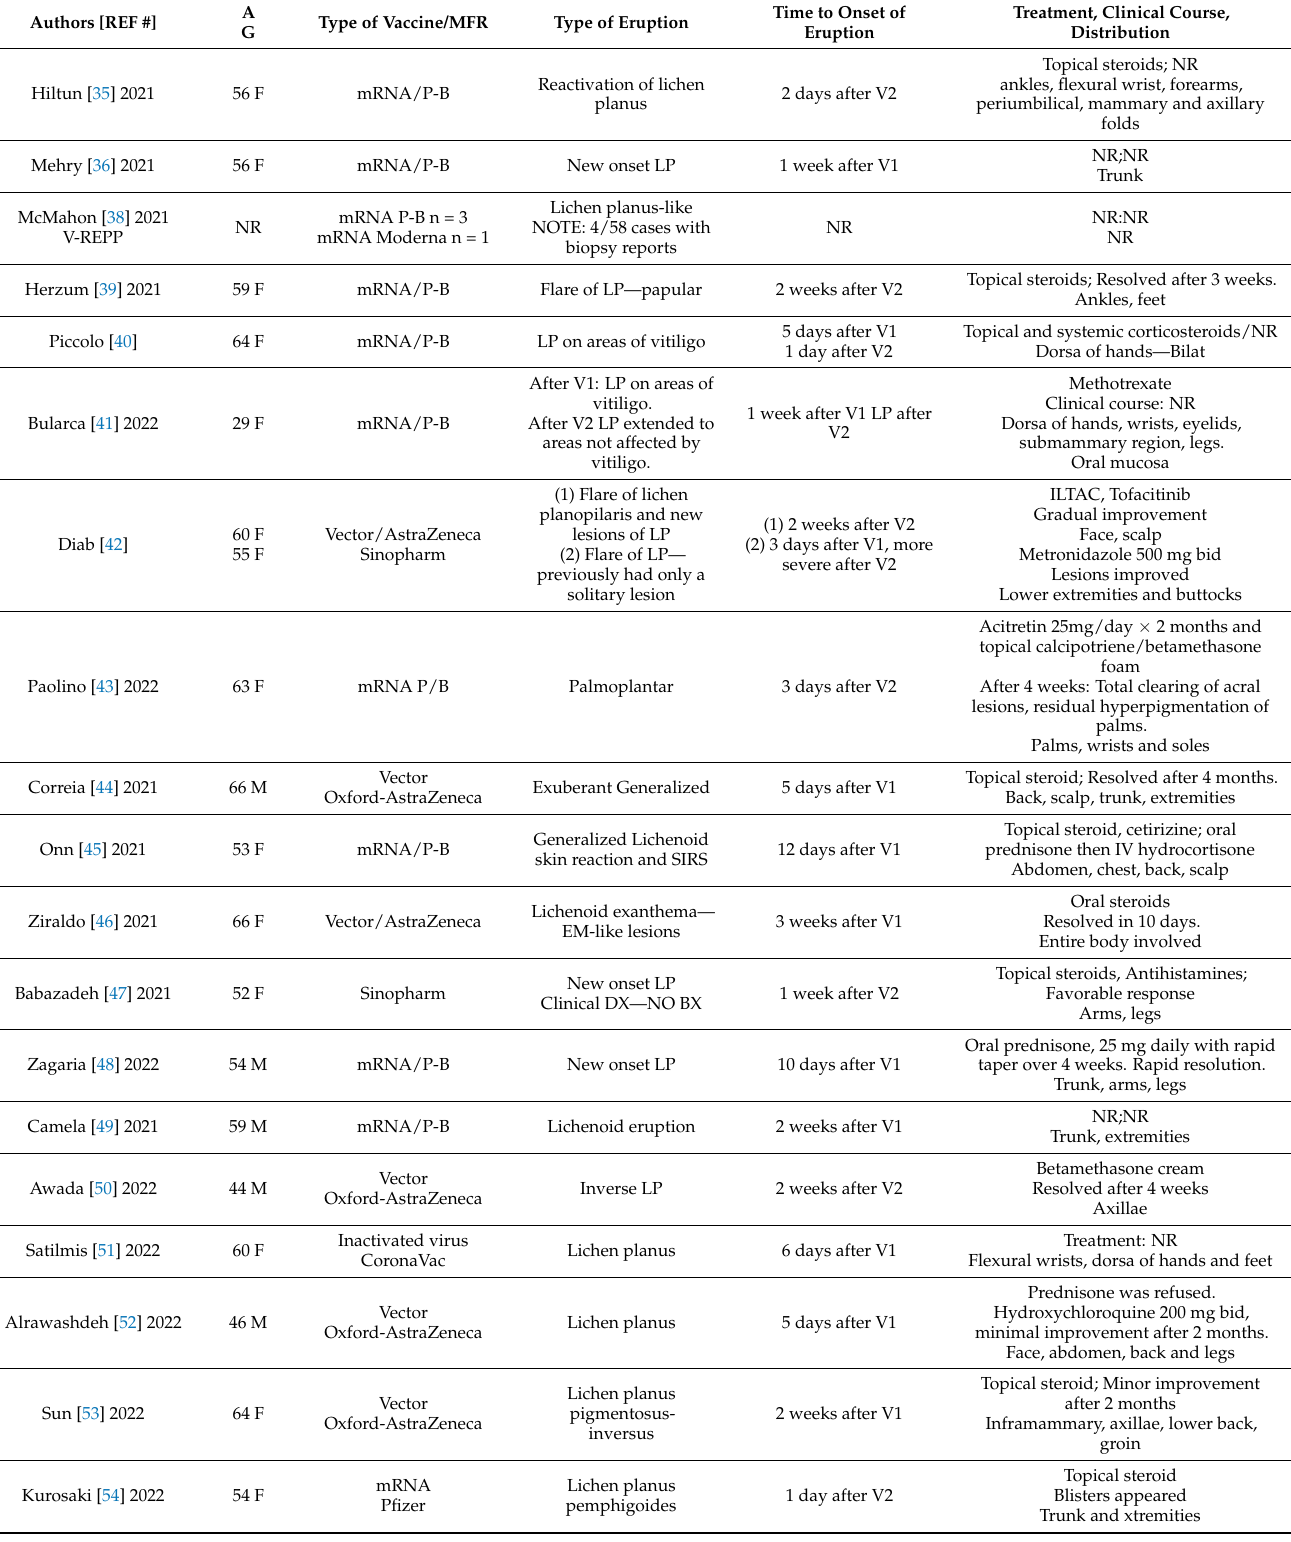
Table 2. Lichenoid euptions following COVID-19 Vaccination—Review of the